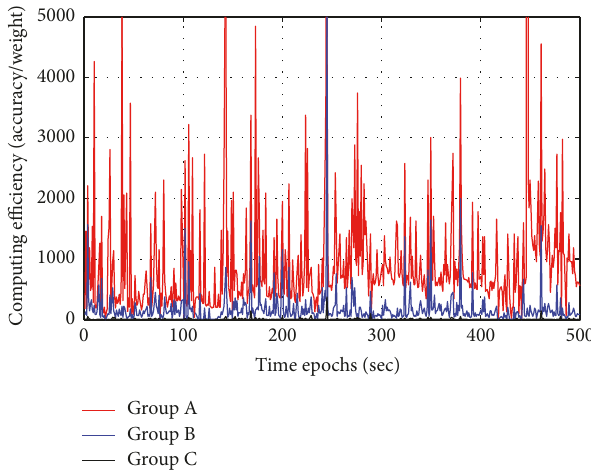
Figure 2: Flowchart of deployment.